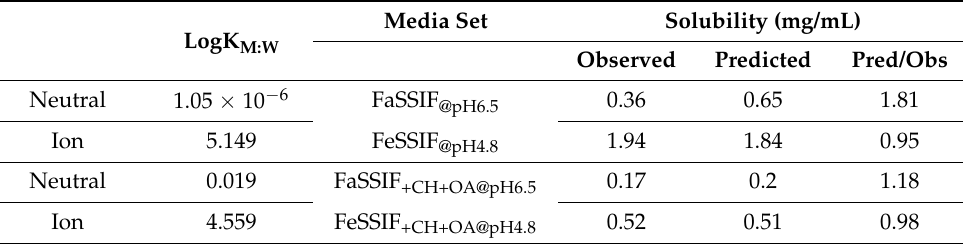
Table 7. LogK M:W estimated values using SIVA v4 predicted solubilities of GSK254 and different sets of biorelevant